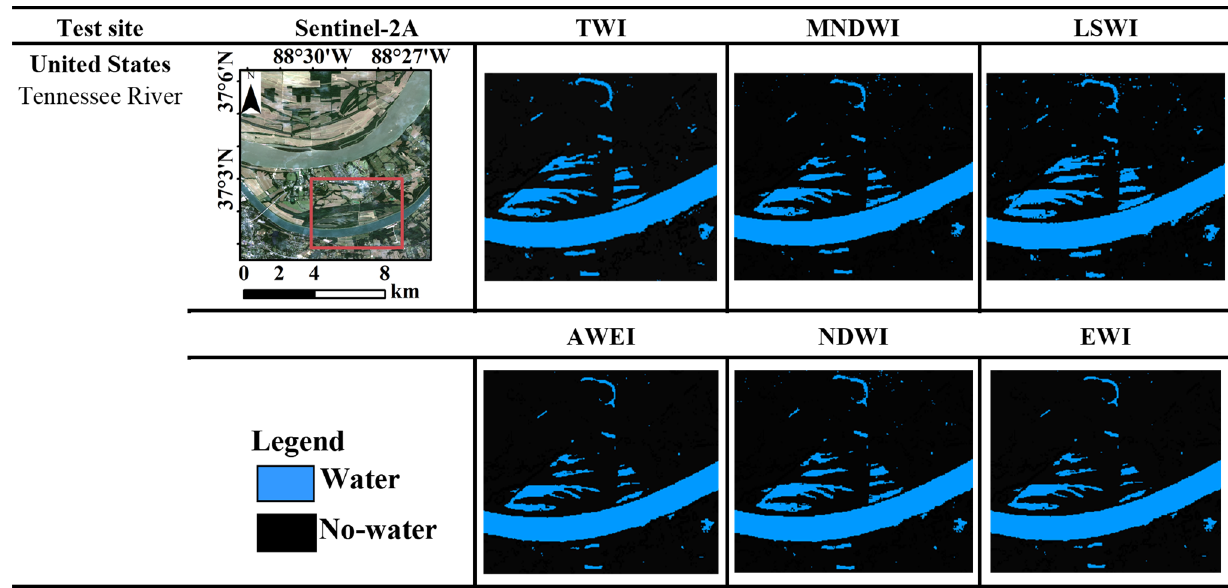
Figure 10. Comparison of water extraction results using seven different water indices at the United States test site. Sentinel-2A color composite, bands 4, 3, 2 coded RGB. The area of the red frame is used to test water bodies’ delineations.